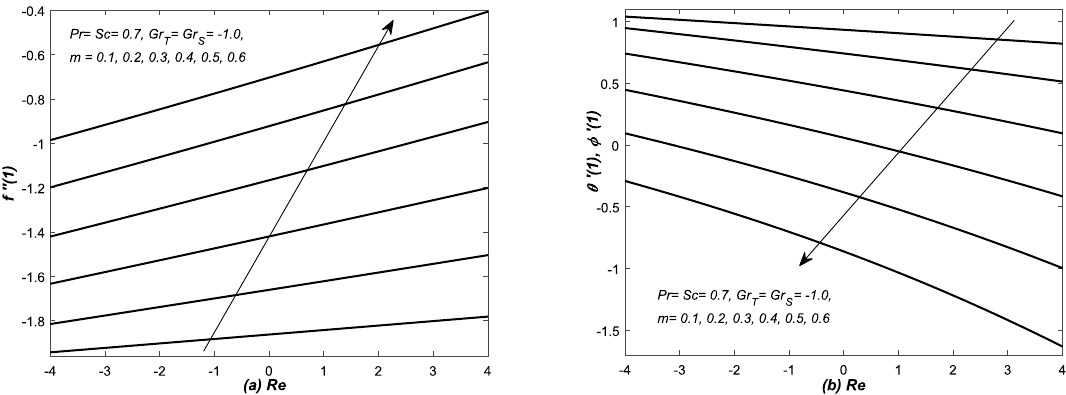
Figure 12. ( a ) Skin friction coefficient f ′′ ( 1 ) and ( b ) heat and mass transfer coefficients are plotted against Reynolds number Re for opposing flow, whereas, different values are assigned to the slope m